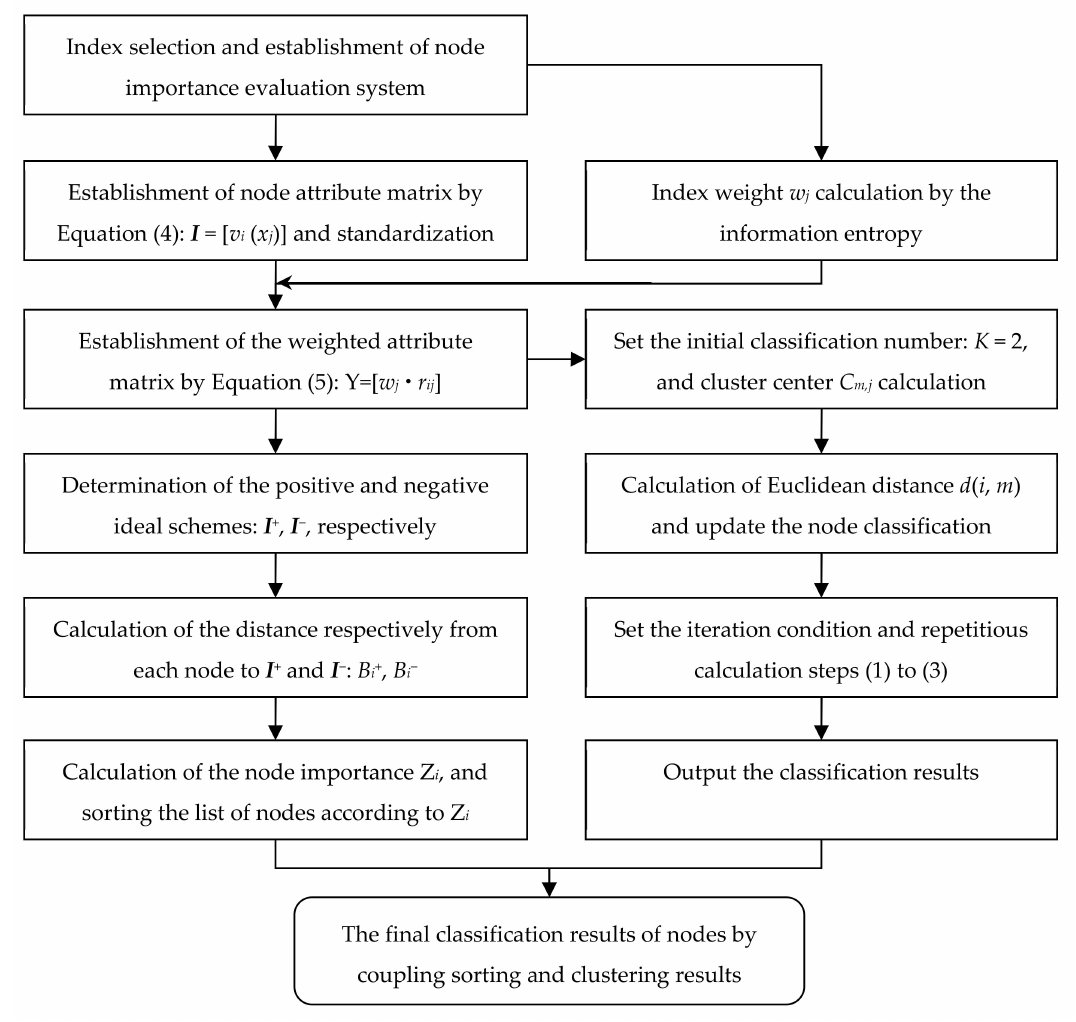
Figure 1. Flow diagram of TOPSIS-DT